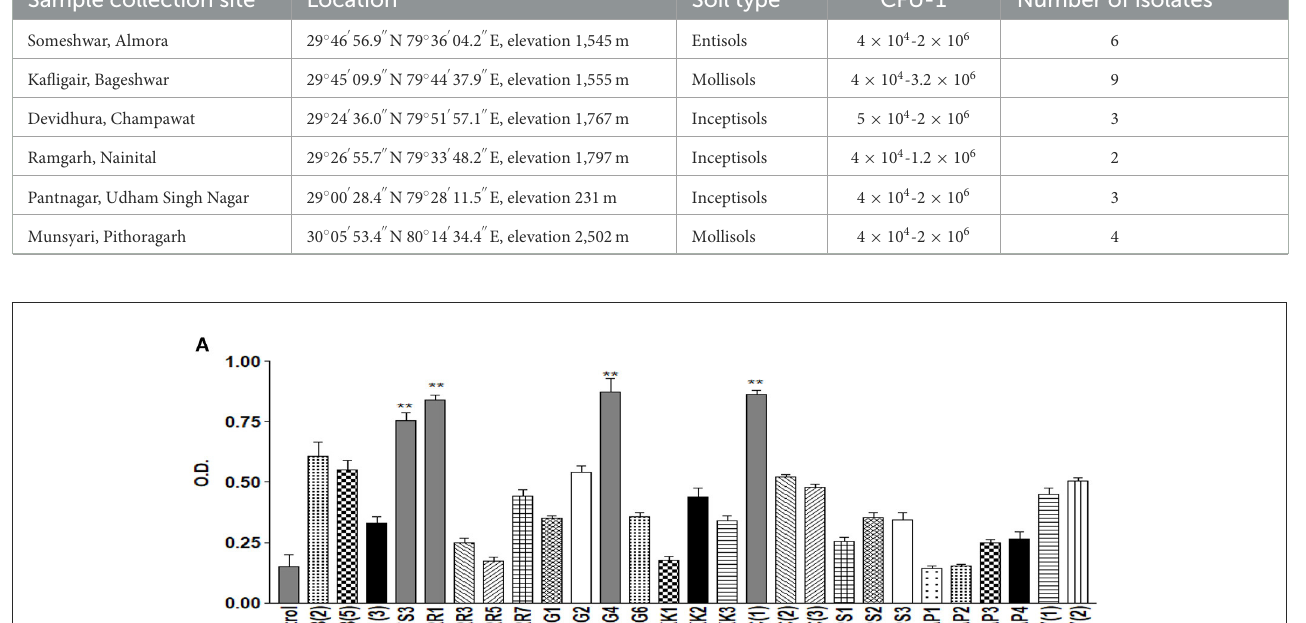
TABLE 1 Geographical location, type of soil, and the number of isolates collected from various districts of the Kumaon region. Sample collection site